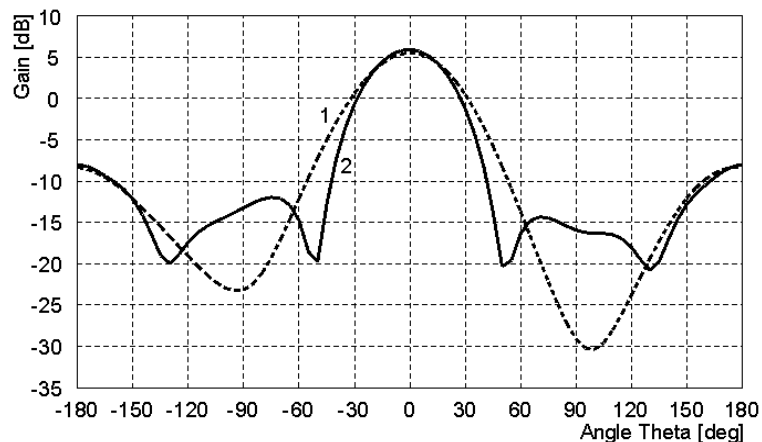
Fig. 1. Antenna pattern of a three-element antenna array (curve 1 in-phase excitation, 2 - non-in-phase excitation).